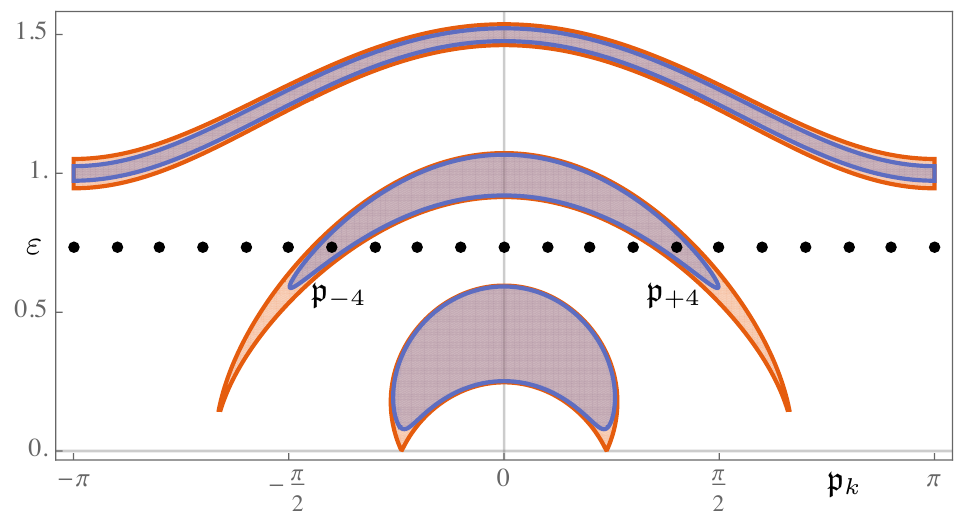
Figure 4 . Instability bands in a periodic quantum quench . We sketch the instability region of Floquet exponents (cid:22) with positive real part (red: Re( (cid:22) ) > 0 : 03, blue: Re( (cid:22) ) > 0 : 05) for the system described in (3.13) as a function of " and p k . We chose the values T 0 ’ (cid:25) , (cid:10) 0 ’ 0 : 3 and (cid:20) ’ 0 : 3. Furthermore, we indicate the discrete momenta p k for a periodic chain with N ’ 20 and " ’ 0 : 735, such that there are two modes with unstable Floquet exponents, namely p (cid:6) 4 = (cid:6) 2 (cid:25)